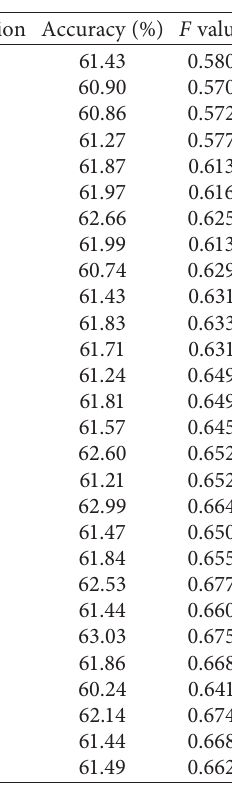
Table 4: Bayesian classifier classification